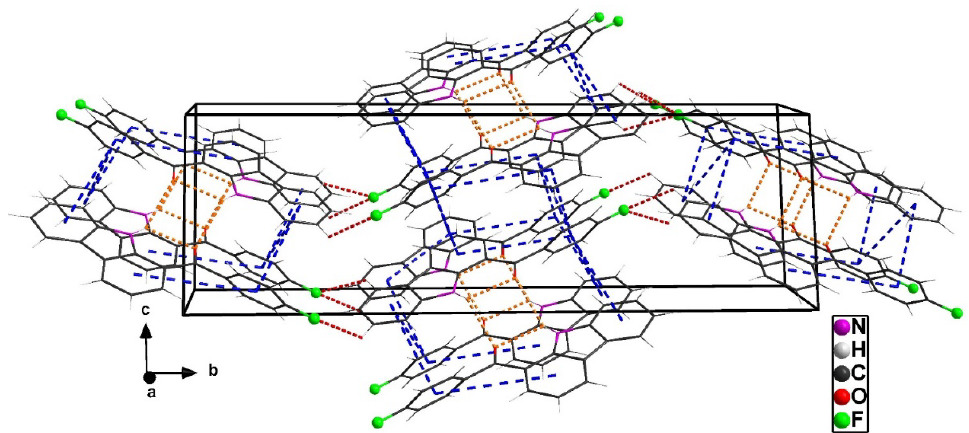
Figure 2. View of the arrangement of the molecules of 1 in and around the unit cell. Blue dashed lines indicate π∙∙∙π - interactions, orange dashed lines the N1−H∙∙∙O1 hydrogen bonds and red dashed lines the F1…H−C5 hydrogen bonds.